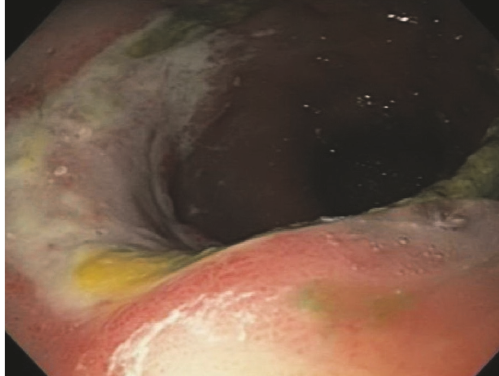
Figure 5: Endoscopic images of the gastric lesion after treatment with